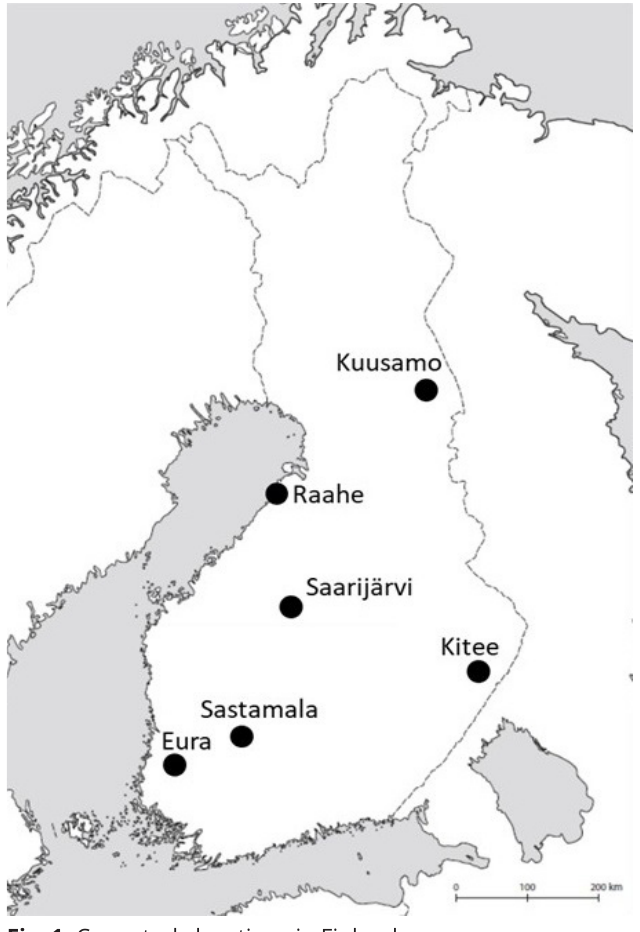
Fig. 1. Case study locations in